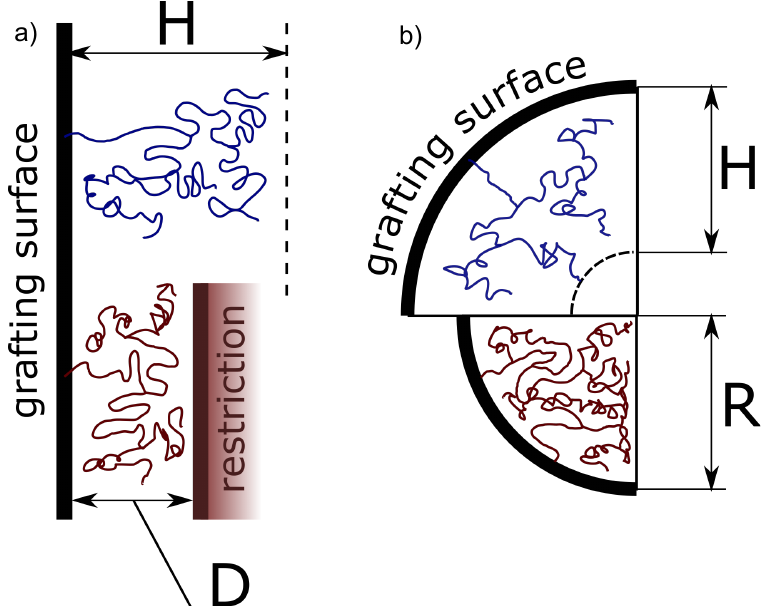
Figure 1. Schematics of a brush formed by first generation dendrons grafted on a planar surface ( a ) or to the inner surface of a cylindrical pore of radius R . In the scenarios depicted with a red polymer chain, the brush pervades the entire space of a planar slit ( a ) or the cylindical pore ( b